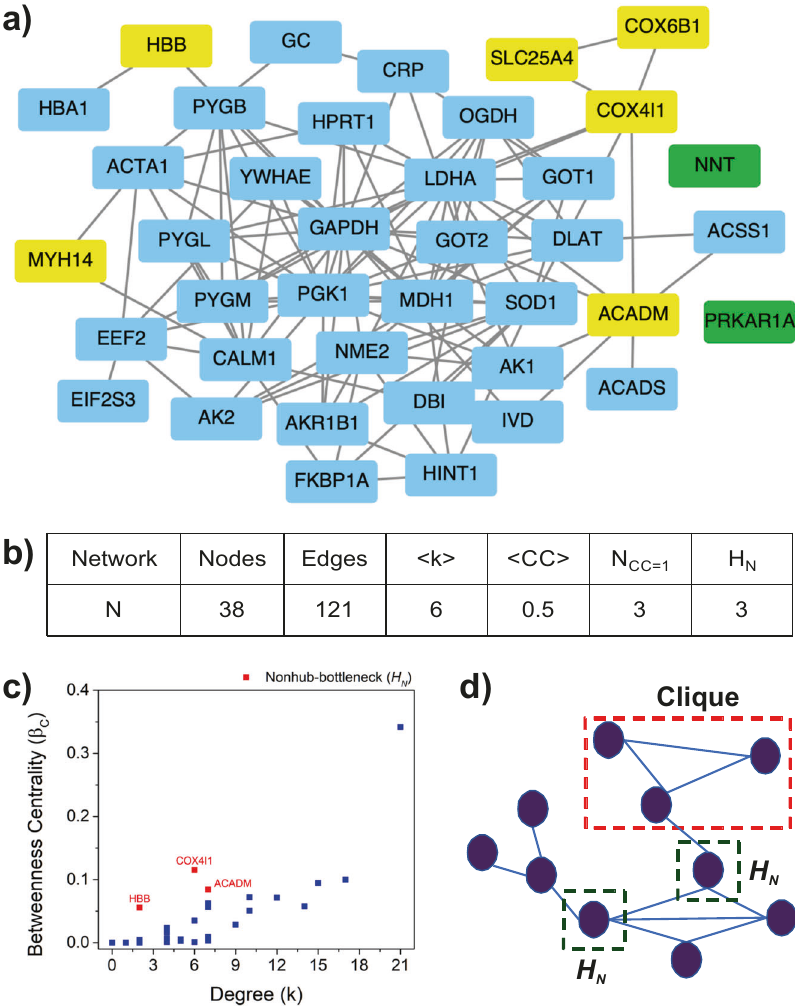
Fig. 2 PPI network. Using STRING database, PPI network for 40 common proteins was constructed. a The network has 38 nodes and 121 edges. Nodes namely PRKAR1A and NNT (Green Boxes) do not interact with any of the other nodes. For statistical analysis, the largest connected component was considered and the unconnected nodes were ignored. The yellow boxes are the set of targets obtained from network analysis which were further studied for their therapeutic potential against cardiovascular diseases. b The table illustrates various structural properties of the network corresponding to 40 common proteins, where N refers to the name of the network followed by the number of nodes and edges in the network. < k> represents the average degree of the network along with the average clustering coef fi cient ( <CC >). N CC = 1 is the number of nodes having CC = 1 , whereas H N represents the nonhub bottlenecks that have a very low degree but high betweenness centrality. c The betweenness centrality Vs degree curve enlisting nonhub bottlenecks ( H N ) as red dots in the graph. d Schematic representation of clique structures (red dotted rectangle) and H N (green dotted square) property in a network. Cliques are closed subgraphs in a network that are vital to the network stability and robustness. H N represents the nodes that act as bridges between consecutive network components like hub nodes and subgraphs. Targeting such nodes helps to maintain network integrity and, therefore, is hypothesized to be ideal pharmacological drug targets in the